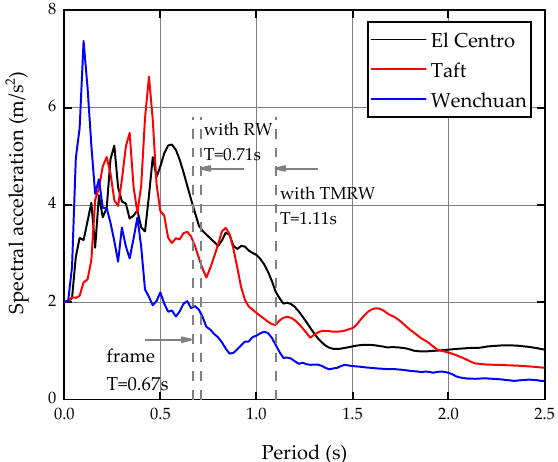
Figure 8. Acceleration response spectra of earthquake waves and the natural frequencies of structural modes.